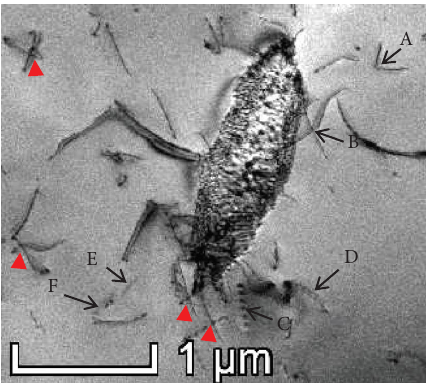
Figure 4: Dislocation morphology of the alloy after creep rupture at 1040 °